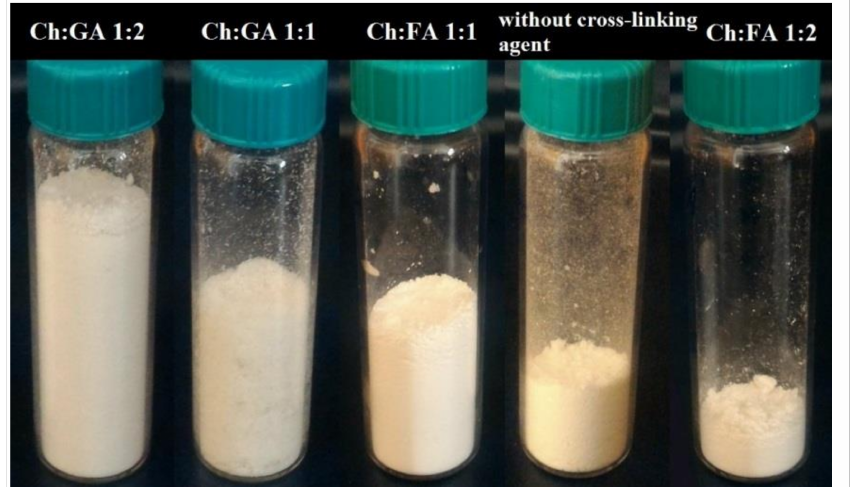
Figure 1. Yield of microcapsules obtained by the spray drying of 100 g of each microcapsule suspen- sion